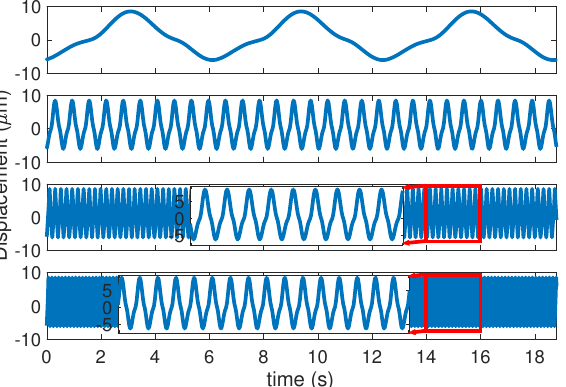
Figure 3. Periodic static hysteresis functions with angular velocities of 1 rad/s, 10 rad/s, 30 rad/s, 50 rad/s from top to bottom,